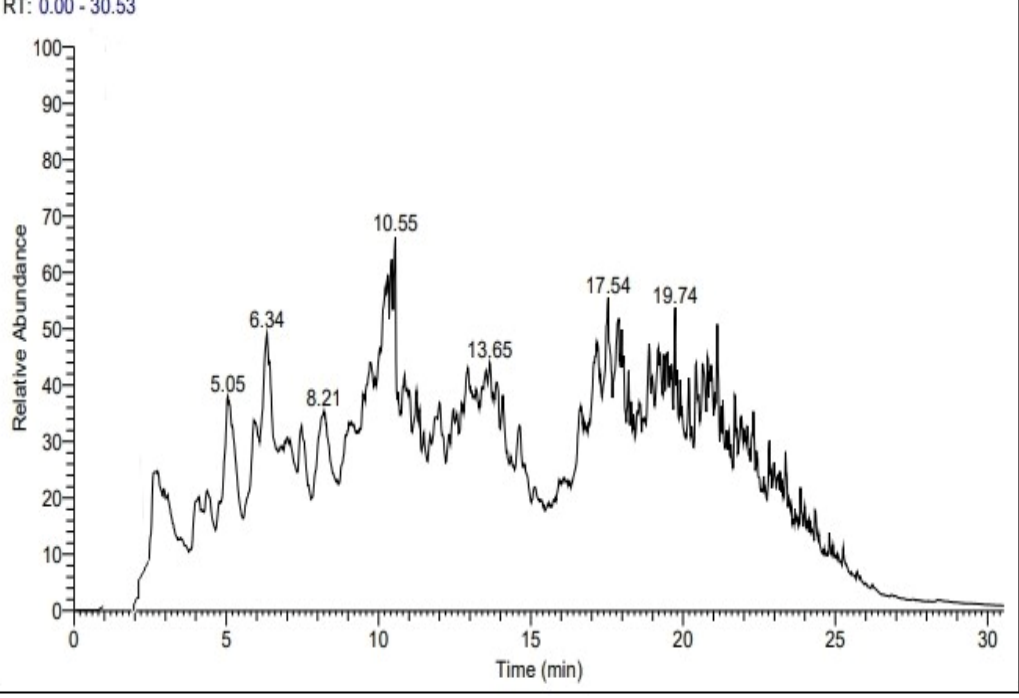
Figure 5. GC–MS of oil produced from PP waste degradation using florisil as the